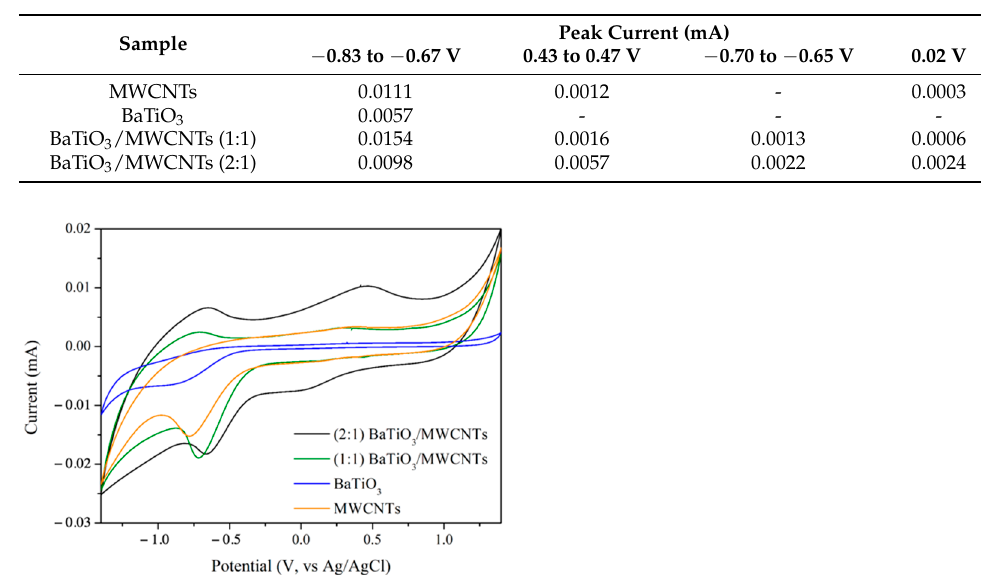
Table 1. Peak currents of MWCNTs, BaTiO 3 , BaTiO 3 /MWCNT composite (1:1)-based electrode, and BaTiO 3 /MWCNT composite (2:1)-based electrode in the presence of 500 µM citric acid.